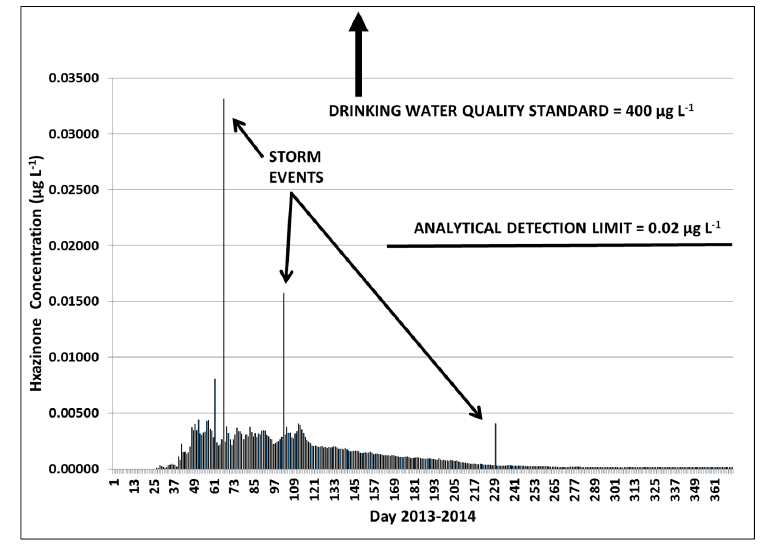
Figure 10. Year 2—modeled daily average concentrations of hexazinone in the Rangitaiki River at the Rangitaiki flow gauge.